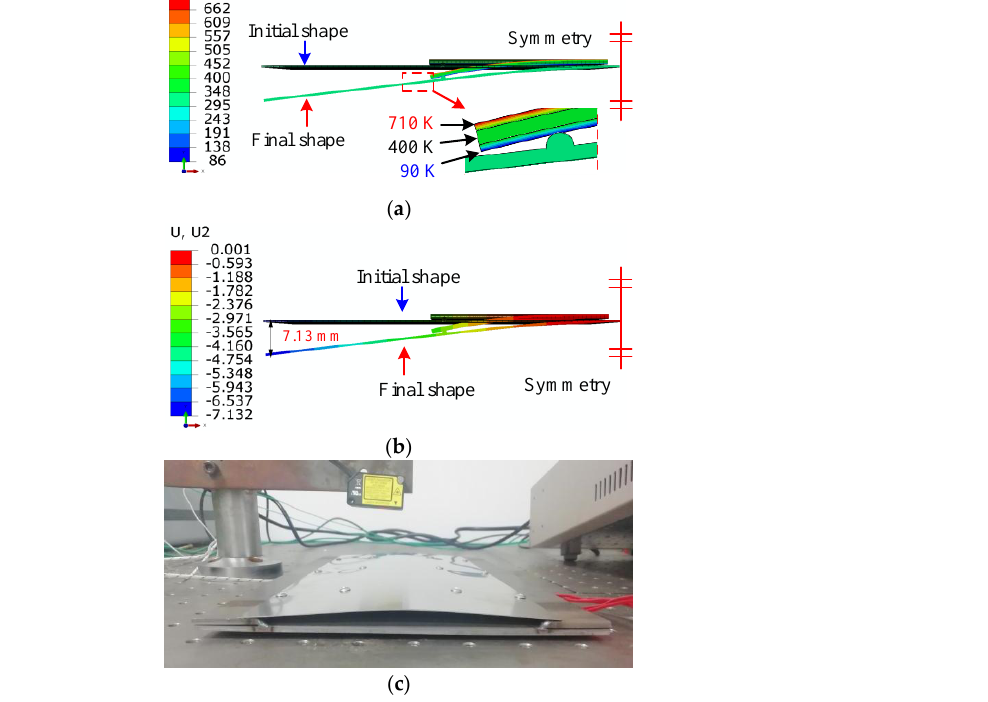
Figure 17. The deformation driven by SMA plate under high-temperature conditions: ( a ) temperature distribution; ( b ) displacement in the Y -direction; ( c ) experimental measurement of deformation.